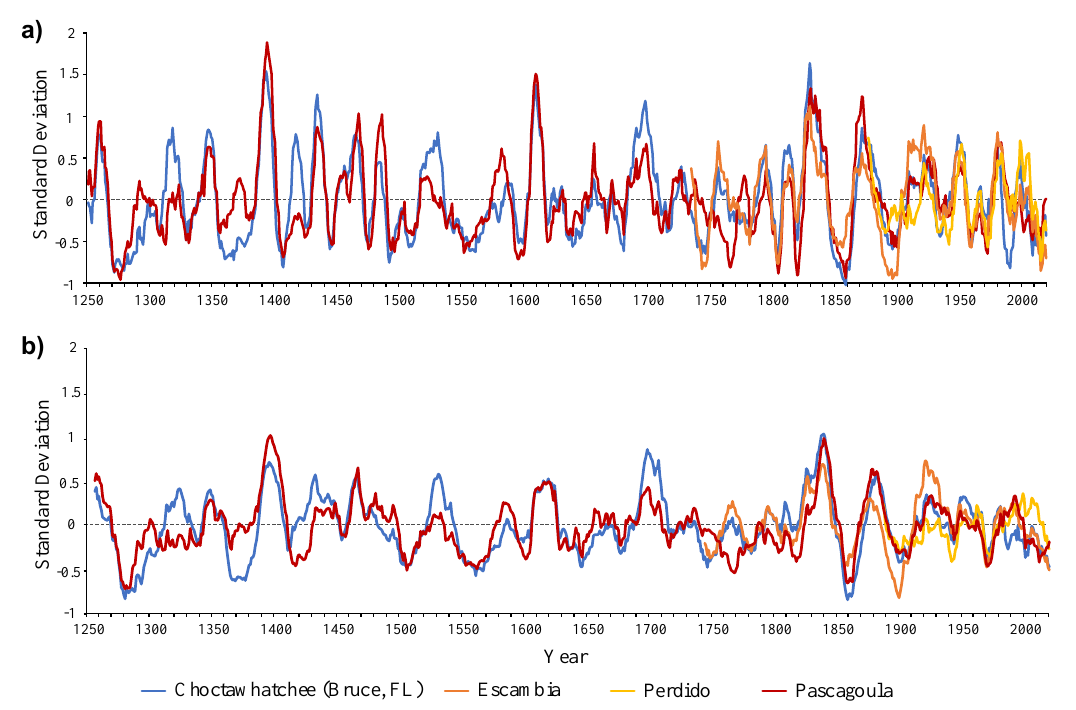
Figure 3. Bias corrected and standardized reconstructed and observed streamflow for the Choctawhatchee, Escambia, Perdido, and Pascagoula rivers (1238–2019) smoothed with a ( a ) 10-year end-year filter (1247–2019) and ( b ) 20-year end-year filter (1257–2019).